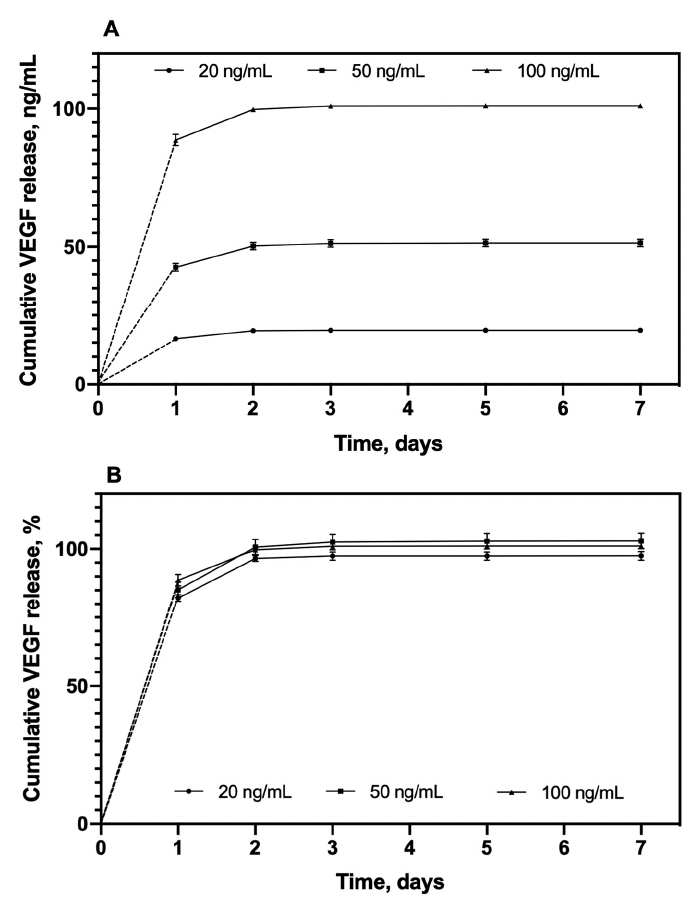
Figure 7. In vitro cumulative release profiles expressed ( A ) in ng / mL and ( B ) as percentage of CHT / PCD sponges loaded with 20, 50, and 100 ng VEGF in ECM culture medium supplemented with 0.5% FCS at 37 °C under static conditions. The test was repeated twice and each in triplicate ( n = 6).